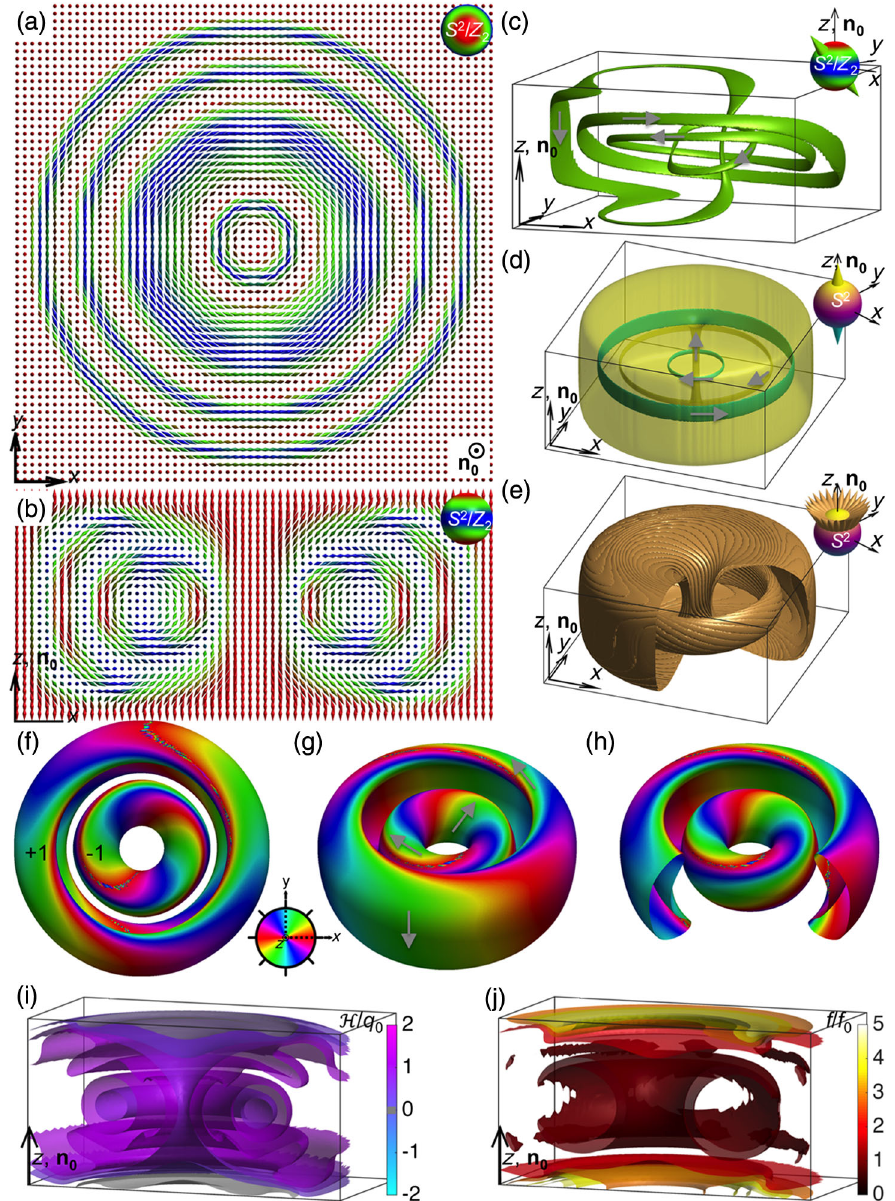
FIG. 7. 3D soliton with complex linking and 4 π twist from its central axis to the far-field periphery. (a),(b) Computer-simulated (a) in-plane and (b) vertical cross sections of the axially symmetric n ð r Þ structure of the 3D soliton depicted using double cones and the color scheme that establishes correspondence between director orientations and the points on S 2 =Z 2 (top right insets). (c) A representative computer-simulated preimage of the hopfion for the diametrically opposite points on S 2 =Z 2 marked by double cones in the top right inset. The preimage is composed of four interlinked closed loops. (d),(e) Computer-simulated preimages of the 3D soliton in a vectorized n ð r Þ (d) for two diametrically opposite points on S 2 corresponding to its north and south poles (top right inset) and (e) for a set of points characterized by a constant polar angle θ and forming a circle parallel to the sphere ’ s equator (top right inset). Note that the preimages in (e) reside on two nested tori surfaces. A large variety of preimages of this soliton are shown in Video 1. (f) – (h) Three representative views on the isosurfaces of θ ¼ π = 2 ( n z ¼ 0 ) colored by azimuthal orientations of n ð r Þ according to the scheme shown in the right-hand side inset of (f). The numbers on top of the tori shown in (f) indicate the linking numbers that characterize the interlinking of colored closed-loop bands and preimages of n ð r Þ corresponding to points on the equator of S 2 =Z 2 . (i),(j) Perspective views of the 3D computer-simulated isosurfaces of normalized (i) handedness and (j) free-energy density for this axially symmetric 3D soliton, with the corresponding color schemes shown in the right-hand side insets. Gray arrows in (c) and (d) and on the green bands of (g) indicate the consistently determined circulations of the preimages. Computer simulations are performed for elastic constants of ZLI-2806 (Table I) and d=p ¼ 2 .